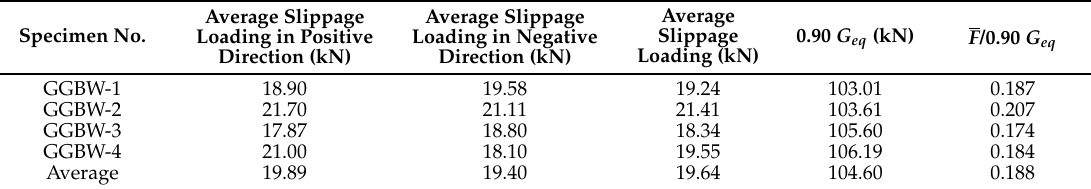
Table 7. Average slippage